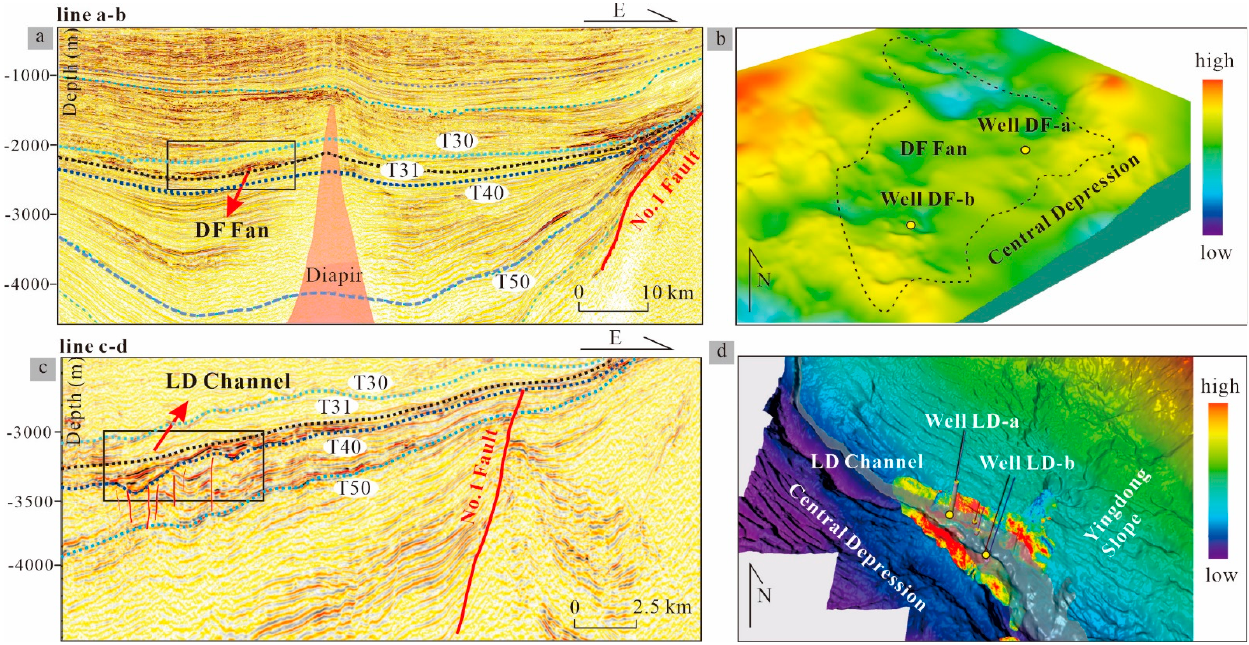
Figure 6. Seismic profiles and regional palaeotopography restorations (see the locations of lines a– b and c-d in Figure 1): ( a ) Seismic profile of the Dongfang fan developed in the second member of the Huangliu Formation between T30 and T31. ( b ) Dongfang Block paleotopography restoration. ( c ) Seismic profile of the Ledong channel developed in the first member of the Huangliu Formation between T31 and T40. ( d ) Ledong Block paleotopography restoration.